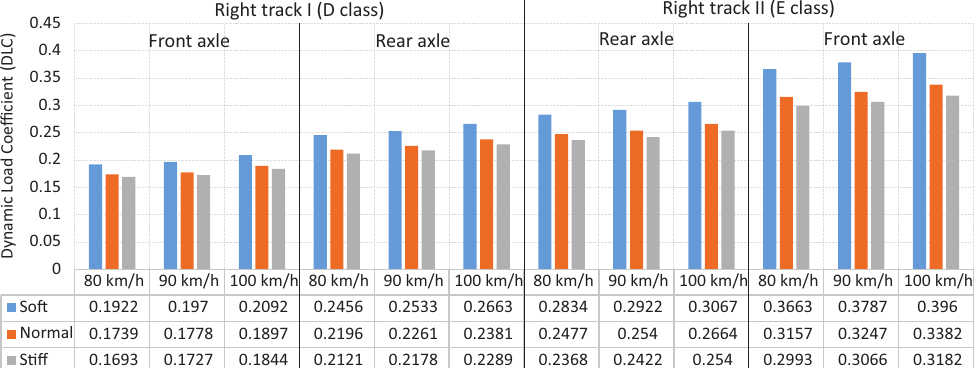
Figure 7. DLC for different road classes, driving speeds and suspension damping